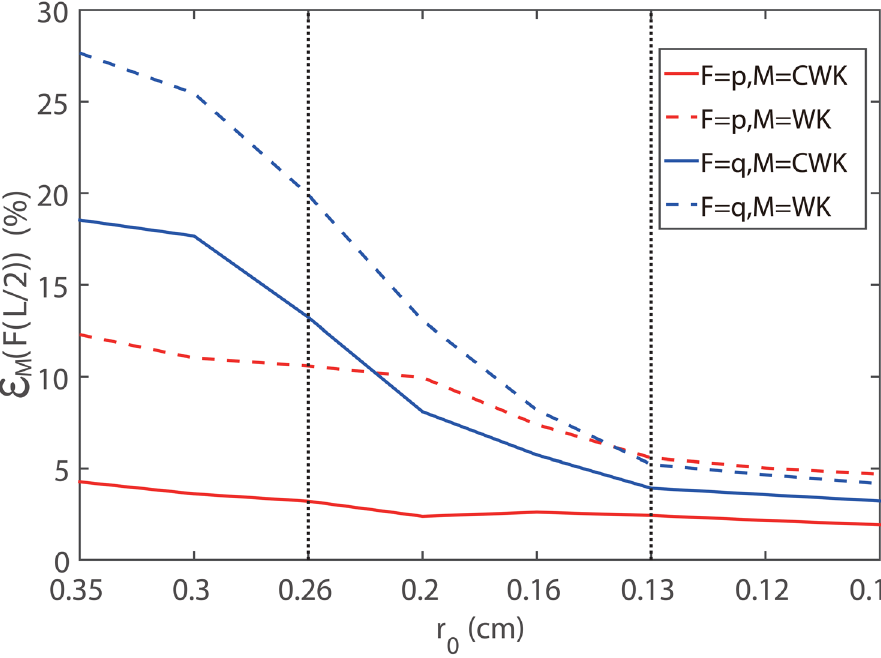
Fig 5. Modeling error induced by the WK and CWK models at the midpoint of a single artery. The x -axis is the unstressed radius of the single vessel. We compute the modeling errors of the blood pressure (red) and flow rate (blue) induced by the WK (dashed) and CWK (solid) model in the single artery case. The two vertical dotted lines indicate the radii used in Fig 4A and 4B, respectively.